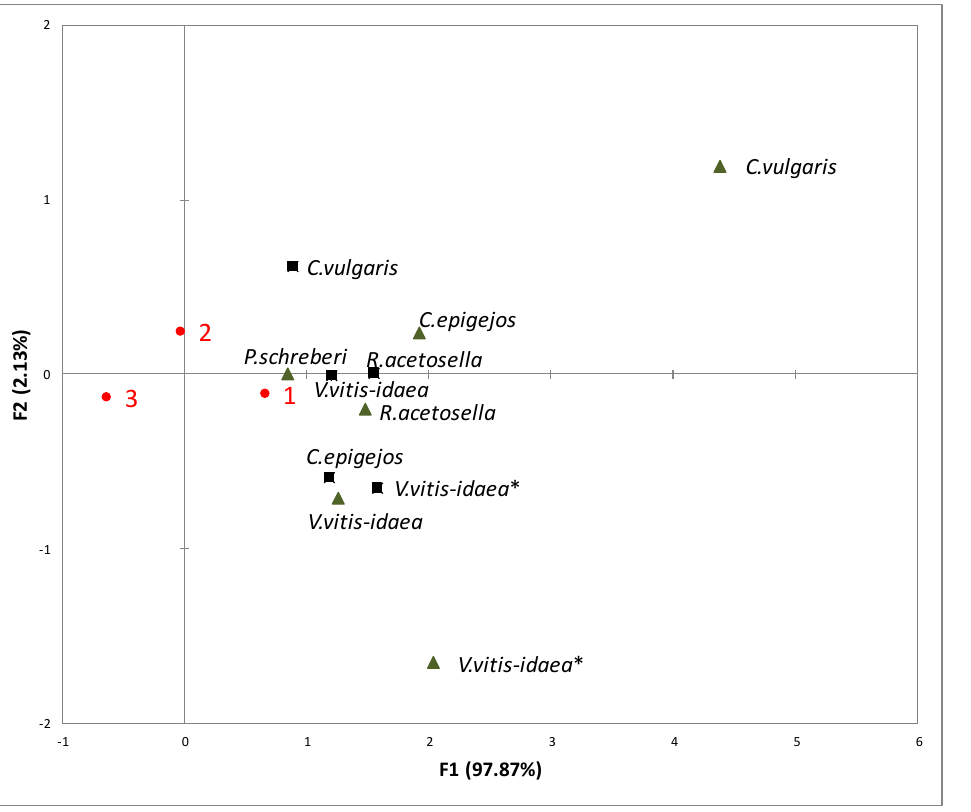
Figure 1. RDA of the impact of the shoots (black triangles) and roots (black squares) of plant-donor aqueous extracts on germination at different climate conditions (1—Current environmental conditions (21.5/16 °C and 400 ppm CO 2 concentration), 2—temperature increases of 4 °C compared to the current conditions (25.5/20 °C and 400 ppm CO 2 concentration), 3—Increasing temperature with higher CO 2 concentration conditions (25.5/20 °C and 700 ppm CO 2 ). (*): dominant species of 2-year-old clear-cuts.